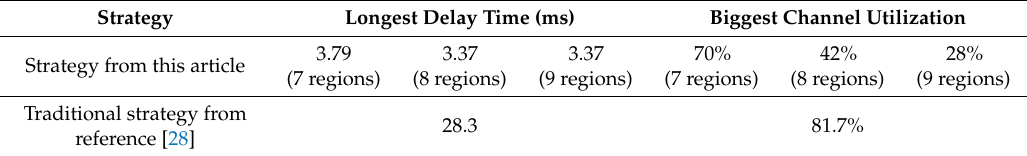
Table 7. Result contradistinction of partitioning using different